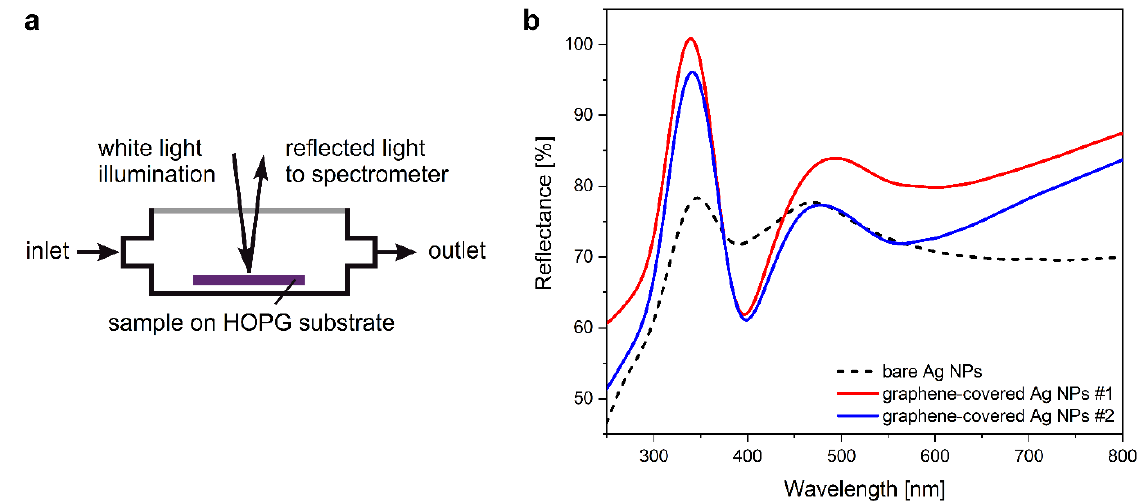
Figure 2. ( a ) Schematic drawing of the aluminum cell used in vapor sensing experiments. ( b ) Optical reflectance spectra of bare (dashed) and graphene-covered Ag NPs measured in air (samples #1 and #2 are similar).